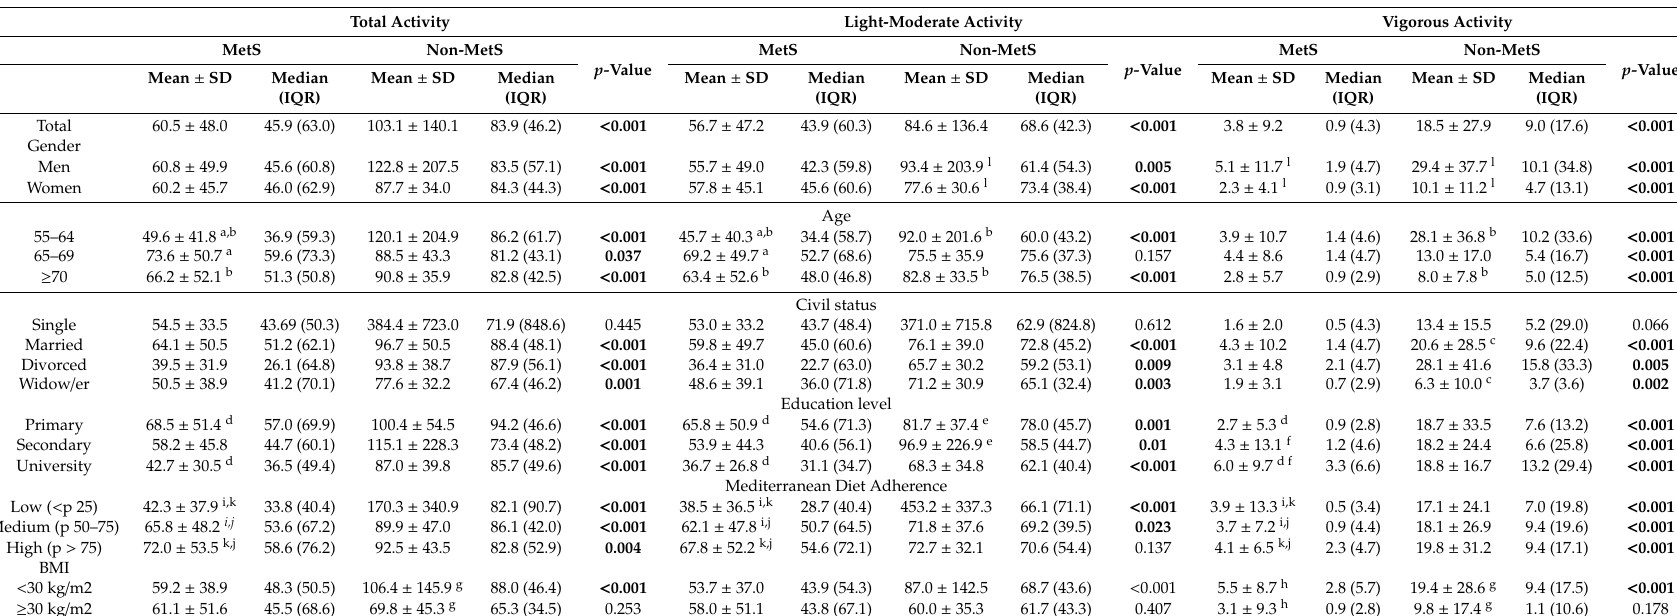
Table 2. Energy expenditure (MET hour / week) in leisure-time physical activity (LTPA) between MetS ( n = 333) vs. non-MetS ( n = 144) participants by sex, age, civil status, education level, adherence to the Mediterranean diet (MD) and body mass index (BMI). Physical activity is divided in light-moderate activity ( < 6 MET) and vigorous activity ( ≥ 6